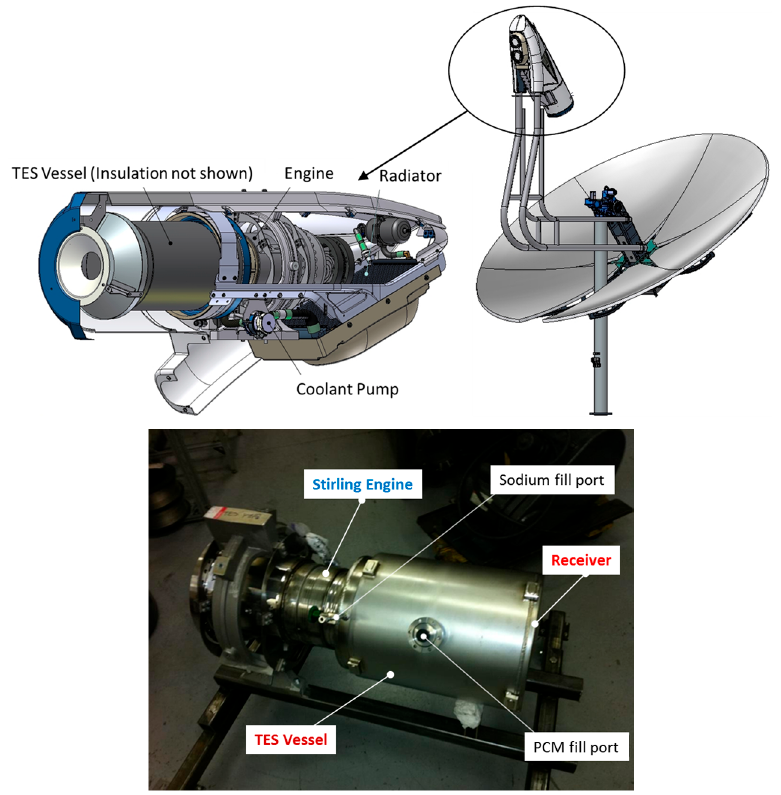
Figure 1. Integrated TES and Dish Stirling CSP.